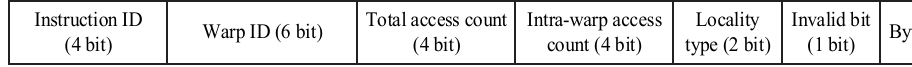
Figure 5. Entries of locality type detection formation table.